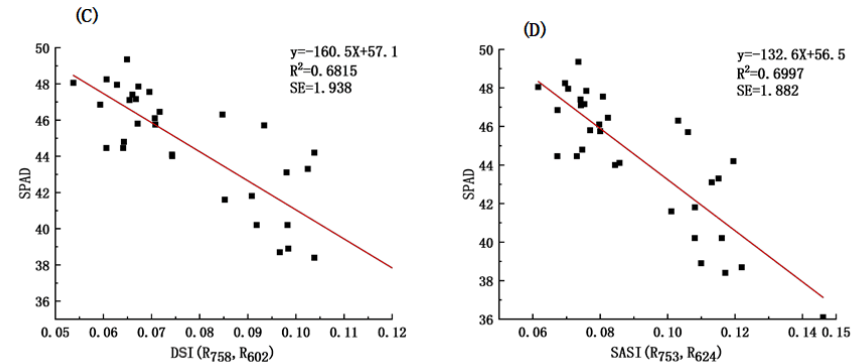
Figure 7. Pictures from A to D show the linear regression of vegetation indices NDSI, RSI, DSI, and